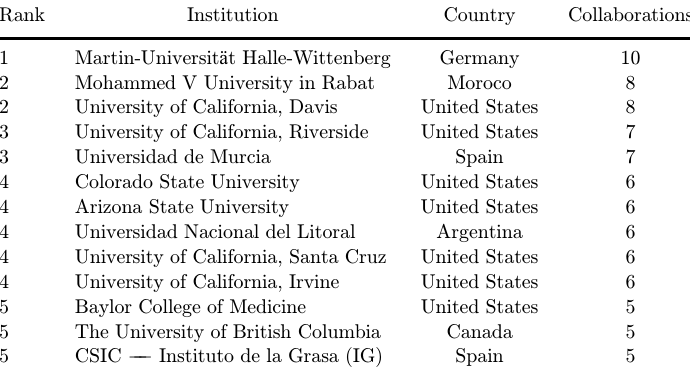
Table 8. Top ranked foreign institutions that collaborate with academic bodies in UADY.